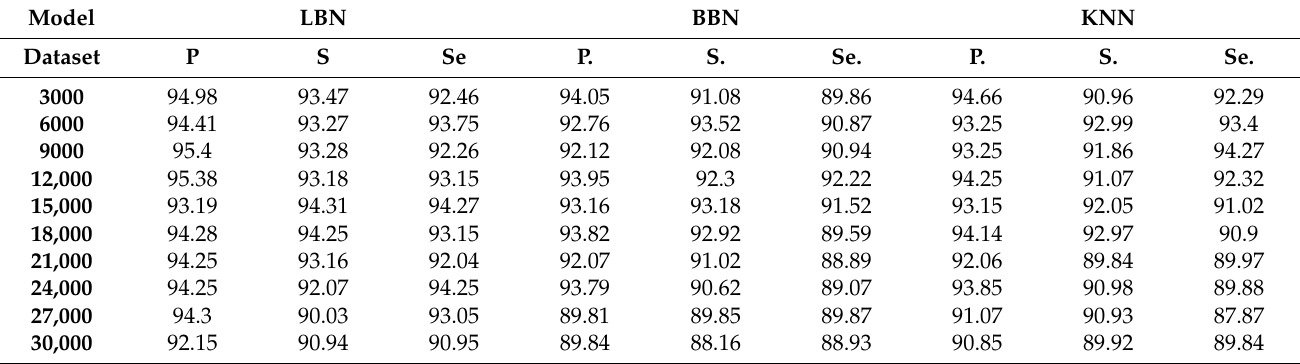
Table 6. The classification efficiency analysis (In %): P—Precision; S—Specificity; and Se—Sensitivity.